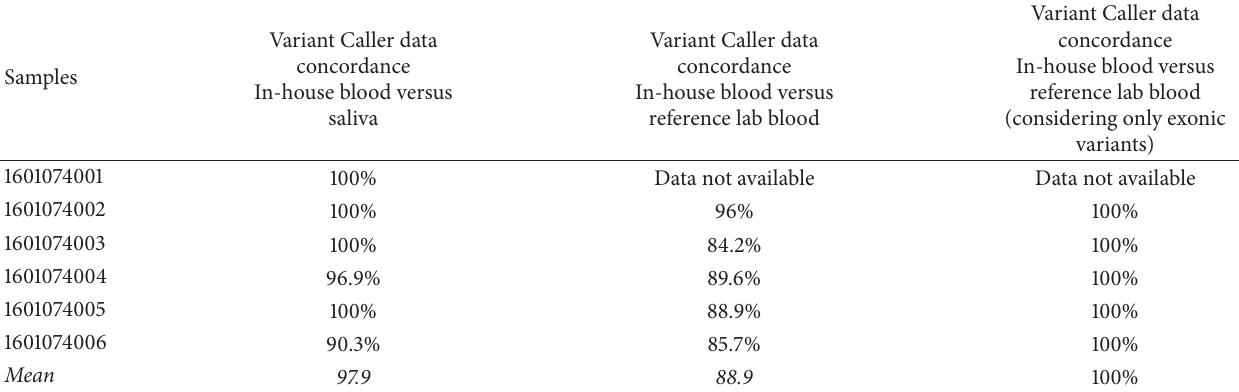
Table 6: Percentage concordance in the Variant Caller data from blood versus paired saliva and blood in-house data versus blood reference lab